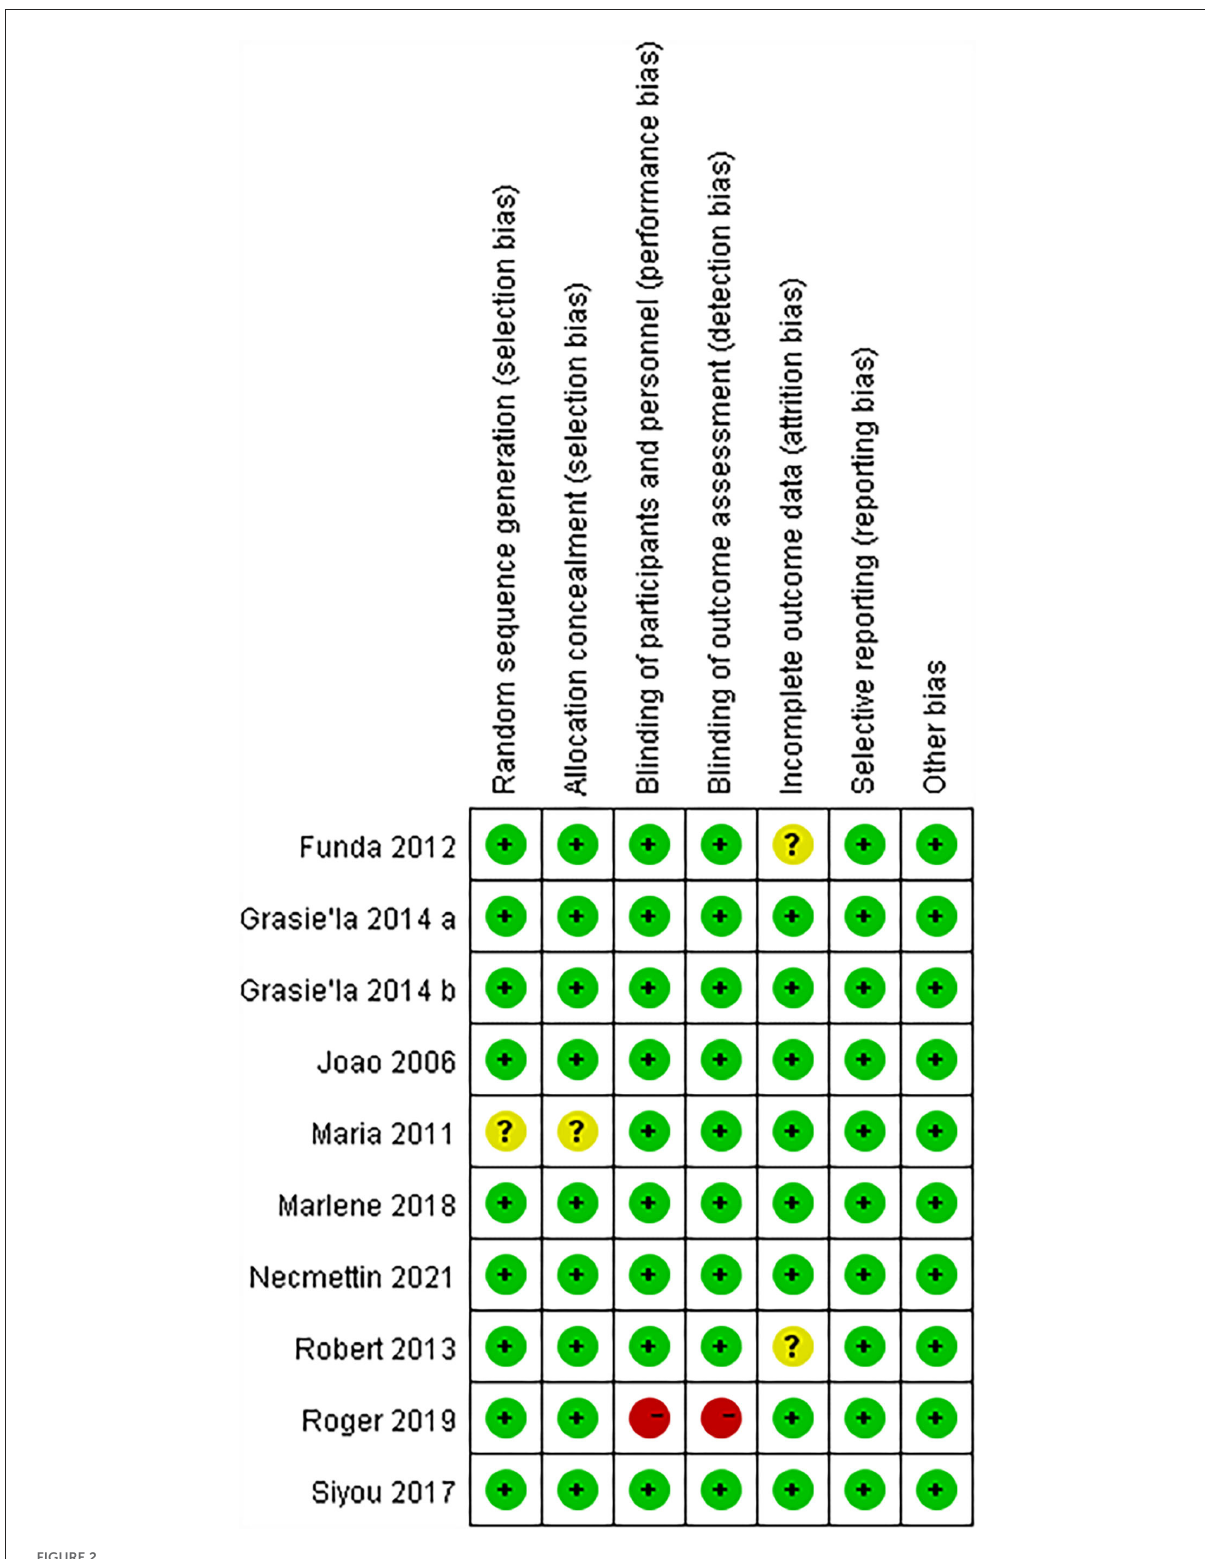
FIGURE2 The risk of bias